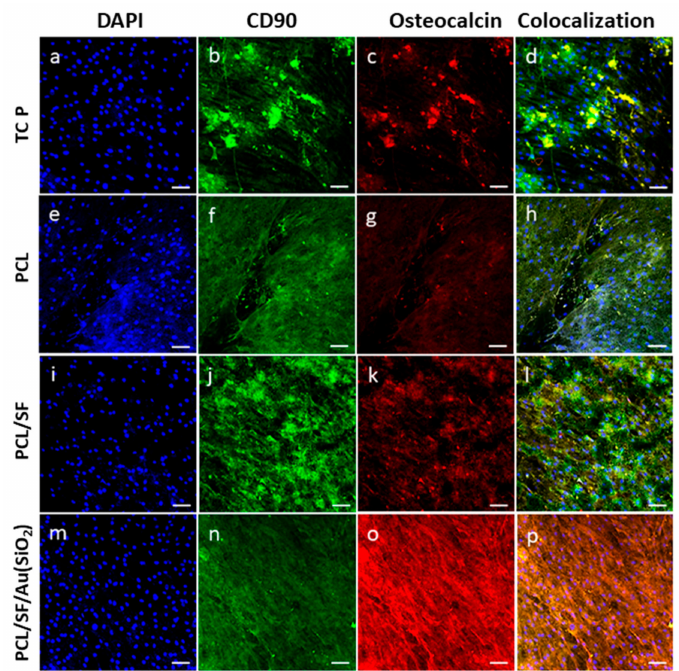
Figure 10. Confocal microscopy images to confirm osteogenic di ff erentiation of MSCs using MSC specific marker protein CD90 ( b , f , j , n ) and osteoblast-specific marker protein osteocalcin ( c , g , k , o ). Merged image showing the dual expression of both CD90 and osteocalcin, characteristic of MSCs which have undergone osteogenic di ff erentiation ( d , h , l , p ) on TCP, PCL, PCL / SF and PCL / SF / Au(SiO 2 ) with the nuclear staining by DAPI (blue fluorescence). Nucleus stained with DAPI ( a , e , i , m ) at 20 × magnification (Scale bar: 50 µ